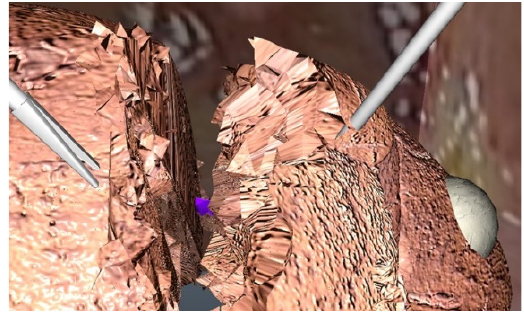
Figure 4. Left hepatic vein as seen during transection of the left lateral segment.